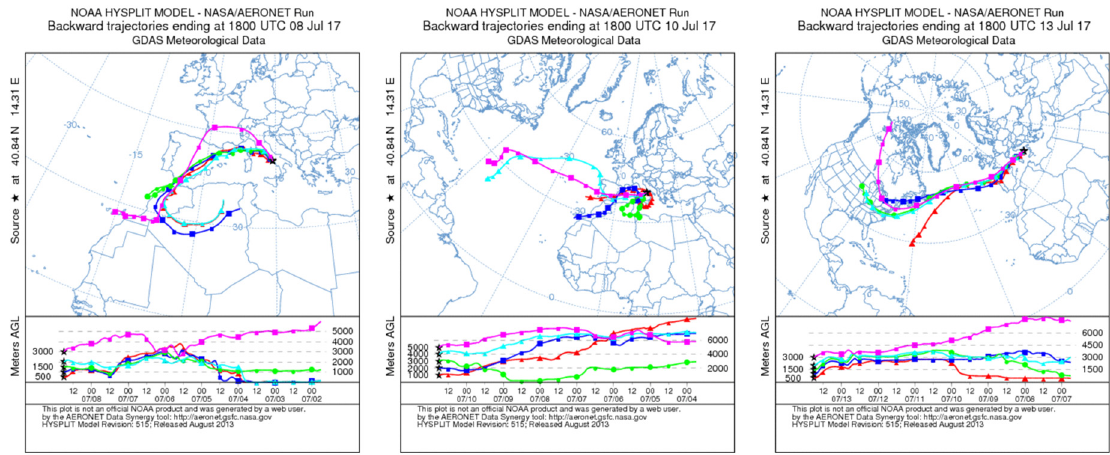
Figure 2. HYSPLIT NOAA model outcomes showing three-day air mass back-trajectories over the measurement area between 500 and 3000 m of altitude. Model results refer to 18.00 UTC of the 8, 10 and 13 of July 2017.